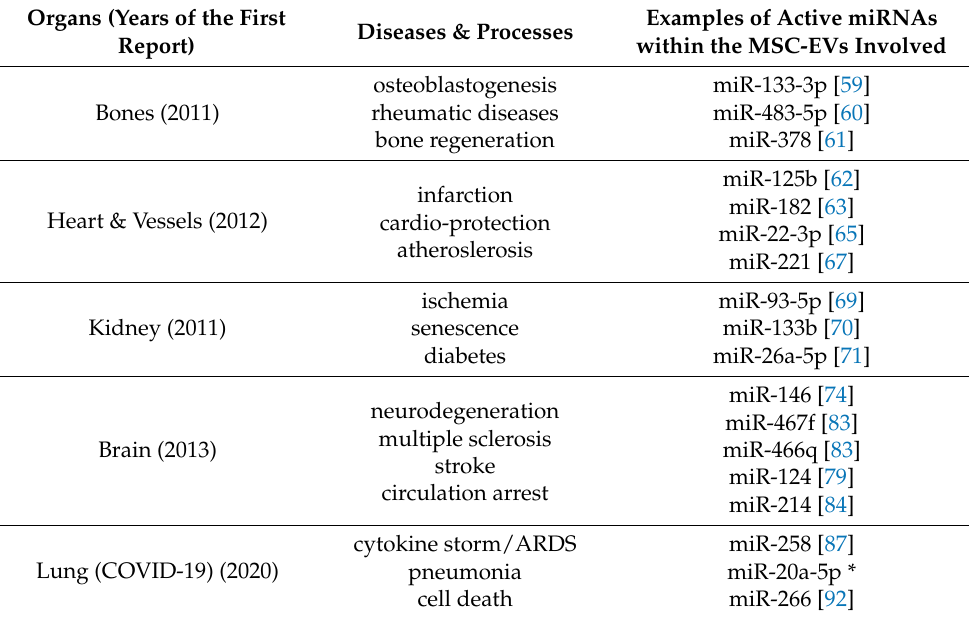
Table 1. MSC-EVs affecting diseases and processes in various organs by the action of specific cargo